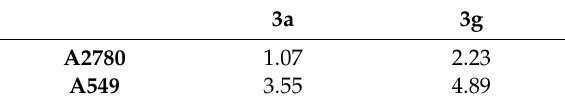
Table 2. IC 50 [μM] values for selected ferrocenyl compounds on different cell lines a . Table 2. IC 50 [ µ M] values for selected ferrocenyl compounds on different cell lines a